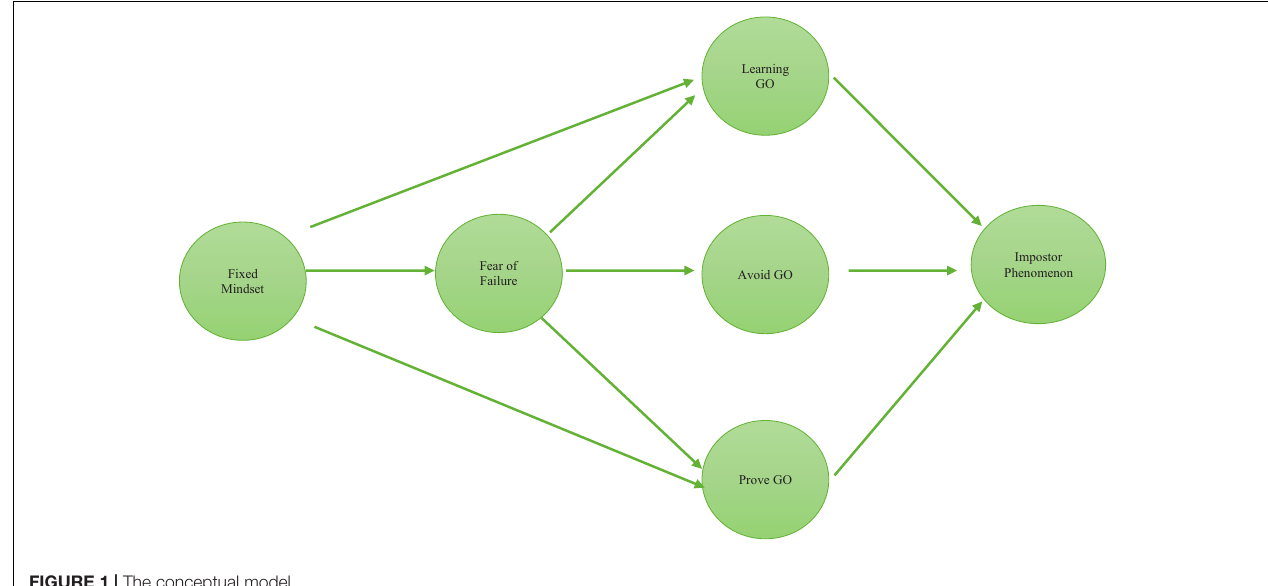
FIGURE 1 | The conceptual